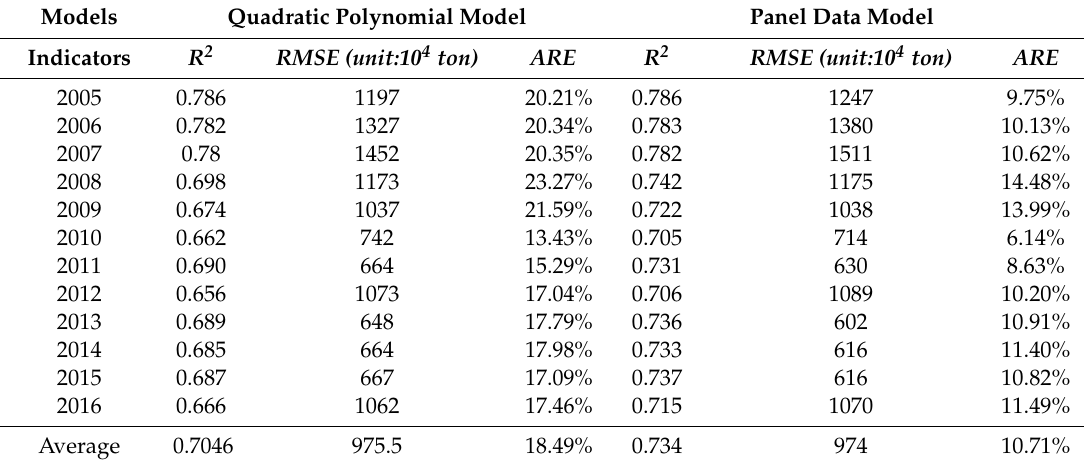
Table 3. Accuracy assessment results of energy consumption estimation in